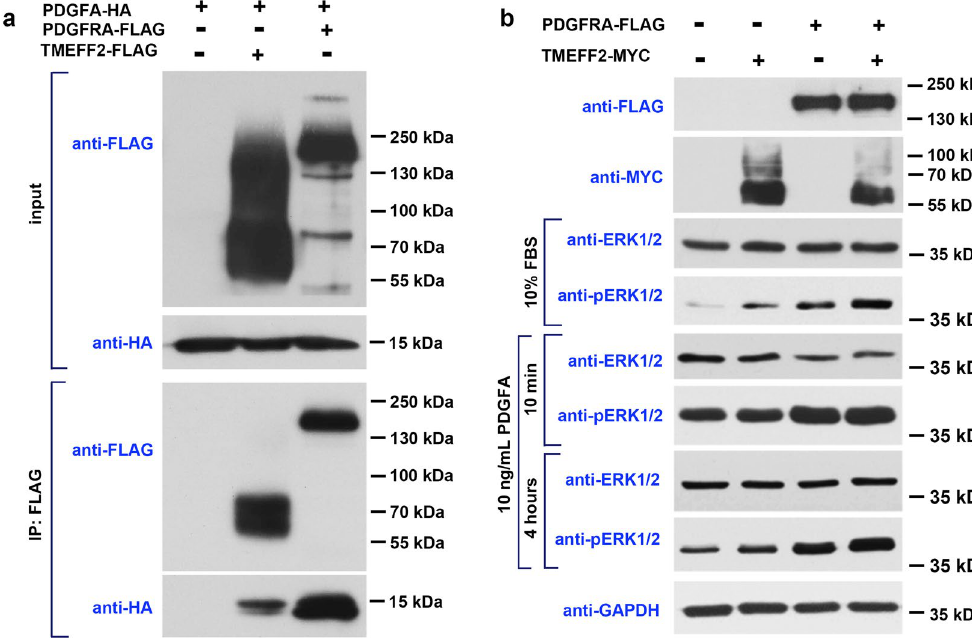
Figure 8. TMEFF2 is a weak PDGFA-binding protein. ( a ) Co-IP showed that the affinity between PDGFA and TMEFF2 is lower than that between PDGFA and its natural receptor PDGFRA. ( b ) TMEFF2 has a weaker effect in stimulating ERK1/2 phosphorylation, compared to PDGFRA, in DMEM media containing 10% FBS or 10 ng/mL